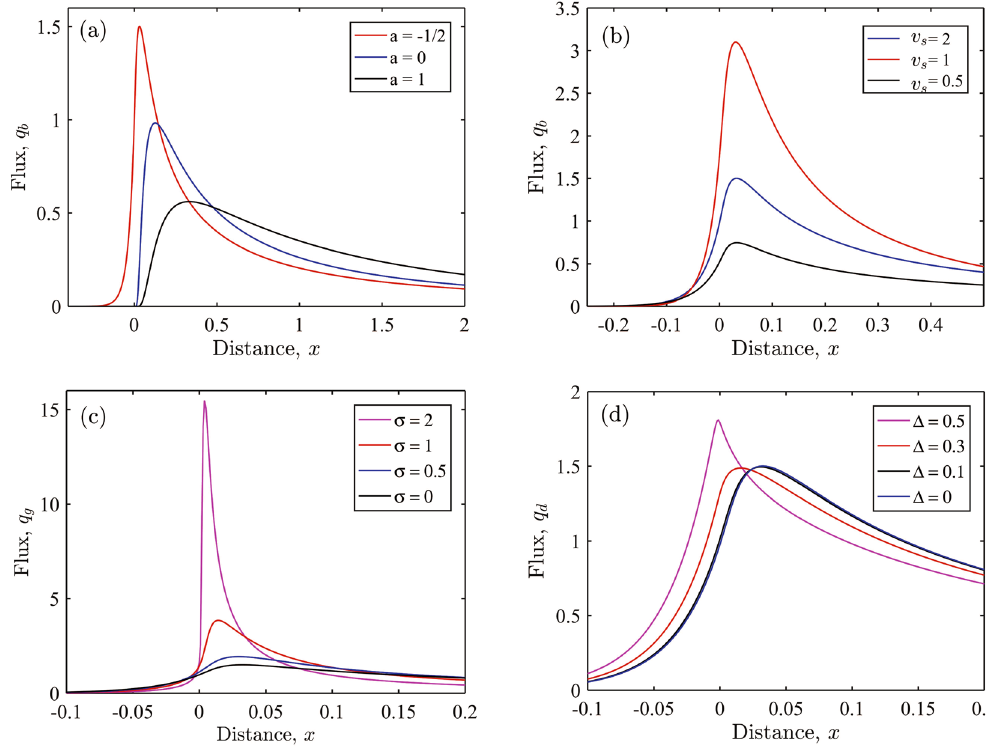
Figure 5. Ash deposition fluxes from an idealised advection-diffusion calculation. Results have been non- dimensionalised and show depositional flux at ground level q s versus distance for different source and wind conditions. Depositional flux for various: ( a ) wind profiles of the form u(z)/U = a + (1 − a)z/H), where U is wind speed at the source height H and a = − 1/2 (a trade wind reversal profile); a = 0 (uniform shear); a = 1 (uniform flow); ( b ) settling velocities v s ; ( c ) grain size distributions, where σ is the standard deviations in ϕ units (the mean ϕ is 5); and ( d ) source thicknesses Δ = Z s /H, where Z s is the source layer depth. Default settings use the trade wind reversal profile a = − 1/2, a settling velocity v s = V s H/ κ = 1 (where V s is the particle settling velocity and κ is the turbulent diffusivity), a standard deviation of grain size σ = 2, and a source thickness of Z s /H =